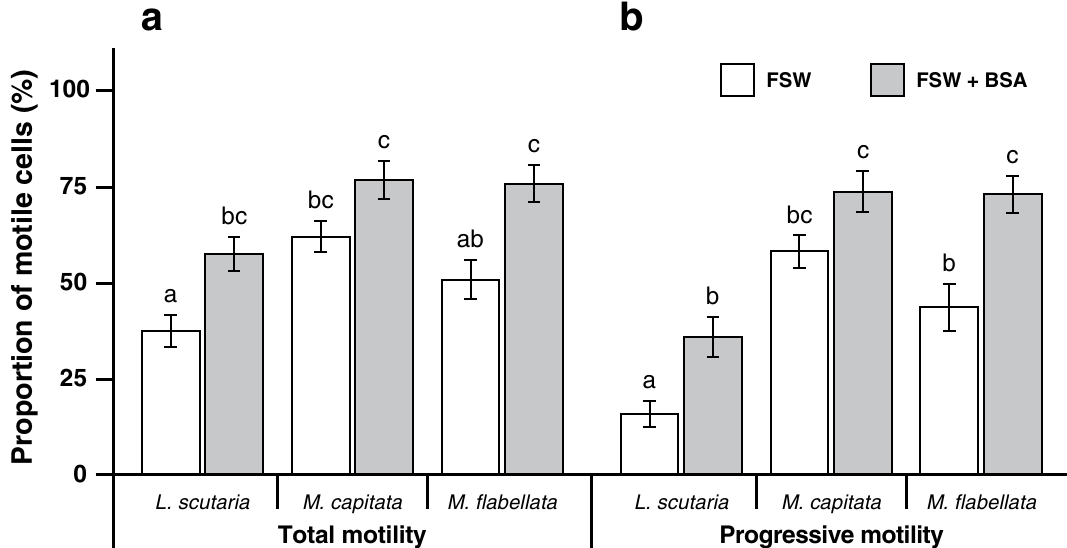
Figure 1. Computer-assisted sperm analysis (CASA) assessment of total ( a ) and progressive ( b ) sperm motilities in samples from Lobactis scutaria (n = 20), Montipora capitata (n = 9), and Montipora flabellata (n = 15) in the presence of filtered seawater (FSW) and filtered seawater with bovine serum albumen (FSW + BSA). Data are presented as mean ± SE, and in ( a and b ) in each panel (reflective of a single species), columns with the same letter are not significantly different ( P <